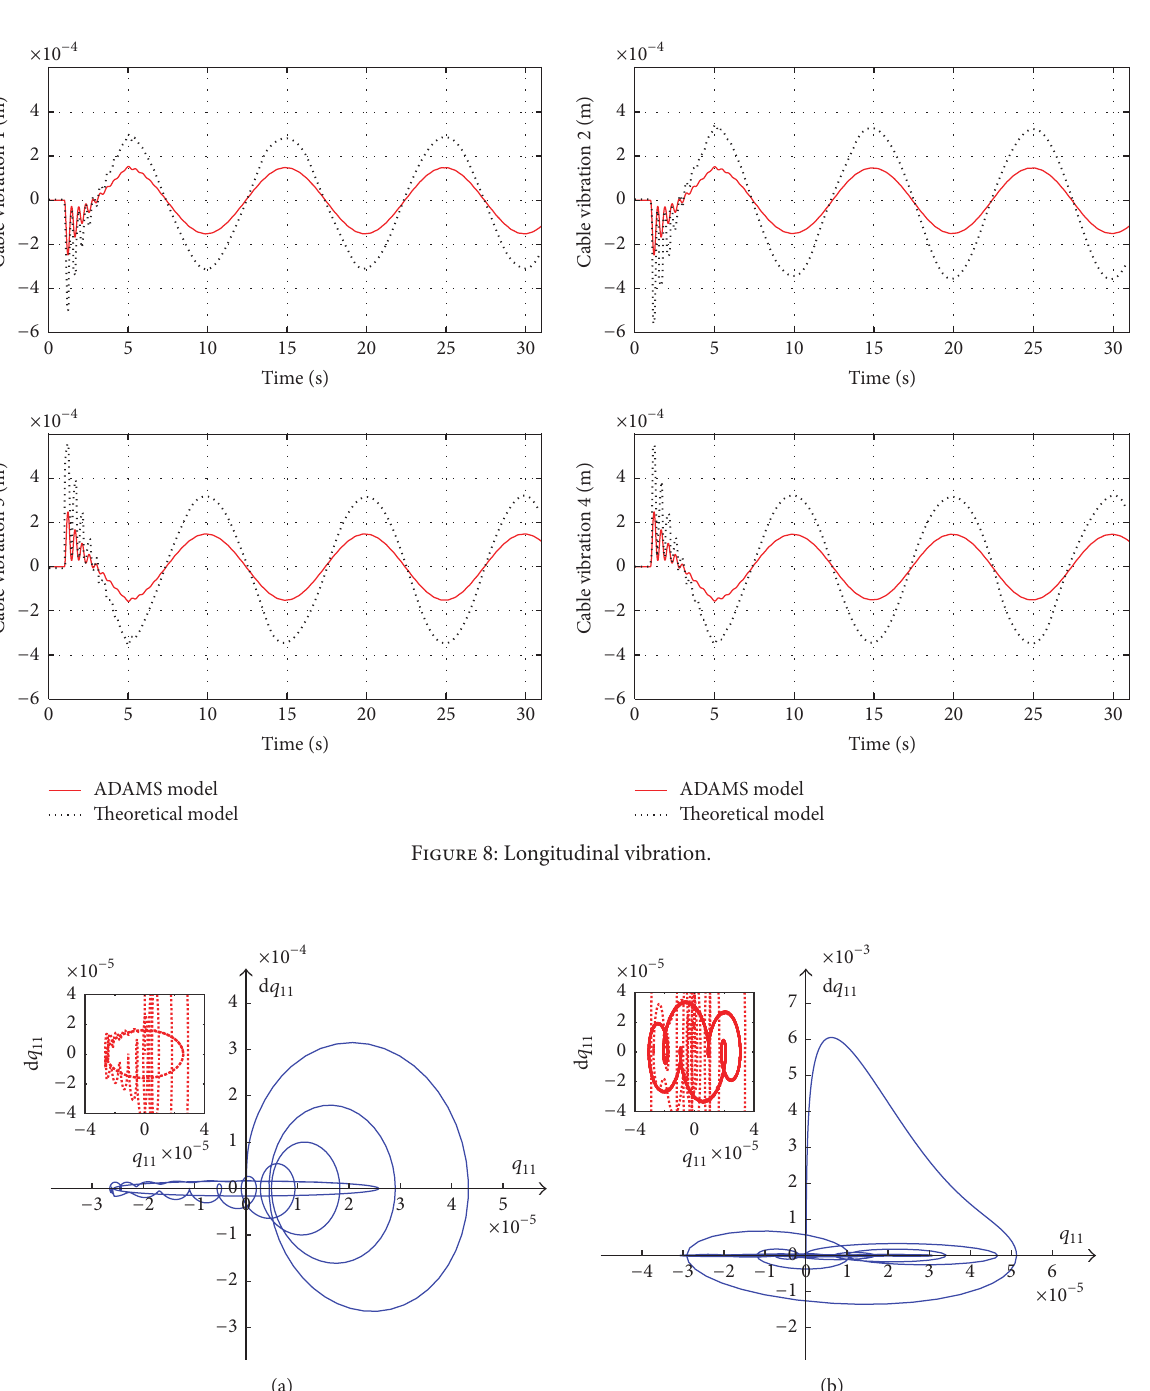
Figure 9: The phase trajectory of 𝑞 11 : (a) no longitudinal excitation; (b) the excitation of the four suspension cables is given by 𝑒(𝑡) = 0.01 sin (𝜋𝑡)